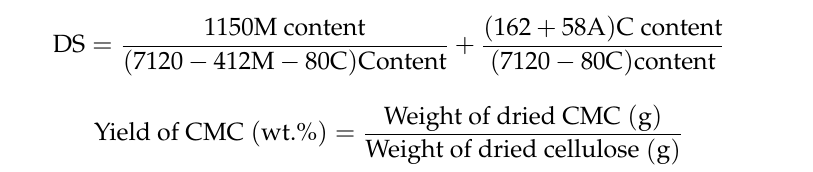
Figure 4. Cellulose production from rice straw and preparation of NaCMC.